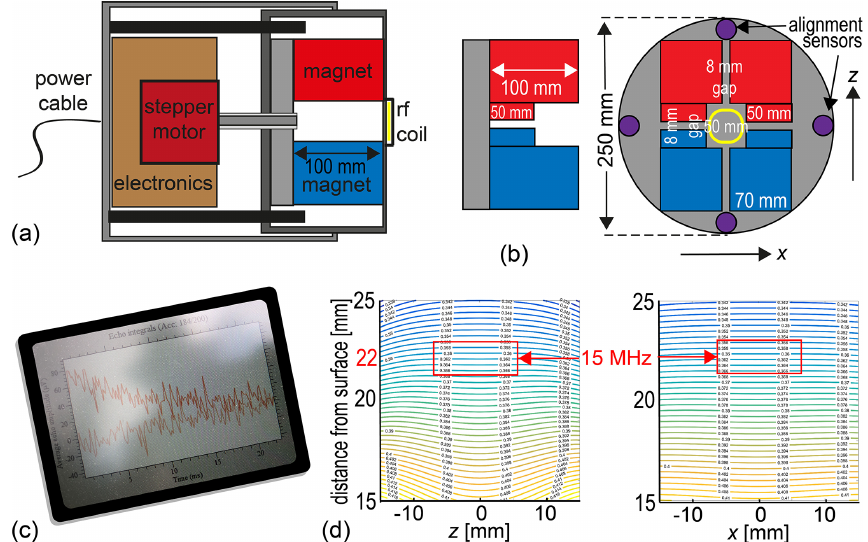
Figure 6. Concept of an all-in-one NMR-MOUSE for depth profiling. (a) Axial cross section through two telescoped tubes showing the stepper motor along with the transmit–receive electronics on the left in the outer tube and the NMR-MOUSE on the right in the inner tube. (b) Arrangement of magnets and alignment sensors. (c) The instrument should be controlled via WLAN or Bluetooth. (d) Calculated field map predicting the position of the sensitive slice at 22mm above the magnet